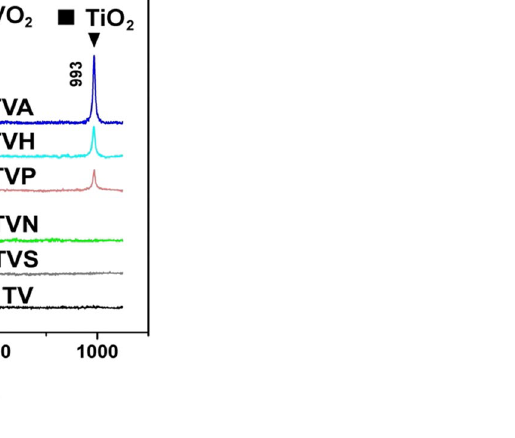
Figure 3. Raman spectra of prepared